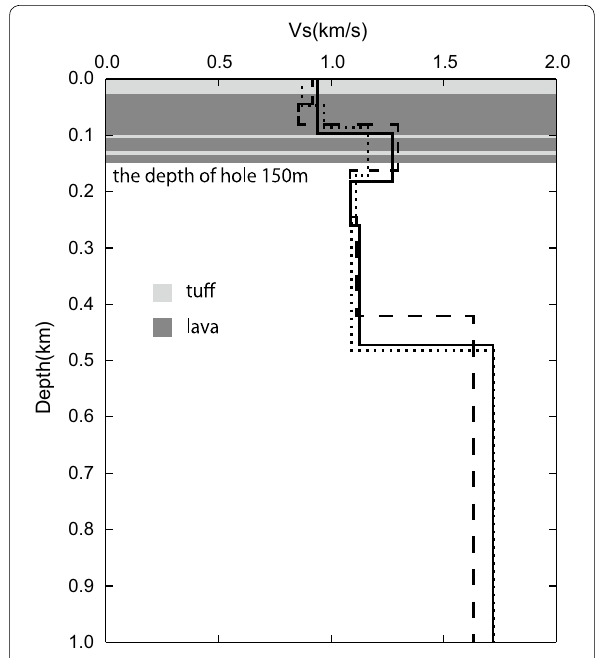
Fig. 9 The one-dimensional velocity structure of the S wave estimated using microtremor observation at the seismic array for 3 h from 0:00 to 3:00 on December 6 (dotted line) and 12 (broken line), 2014, and their average (solid line). The results of the analysis show that there is a low-velocity surface layer up to a depth of 100 m, a high-velocity layer of 1.2–1.3 km/s at a depth of 100–180 m, a low-velocity layer of 1.1 km/s at a depth of 180–480 m, and a high-velocity layer of 1.7 km at a depth of 480 m or more. The dark gray and light gray layers show lava and tuff layers obtained by the borehole survey of a depth of 150 m. (Reproduced with permission from Ossaka et al.